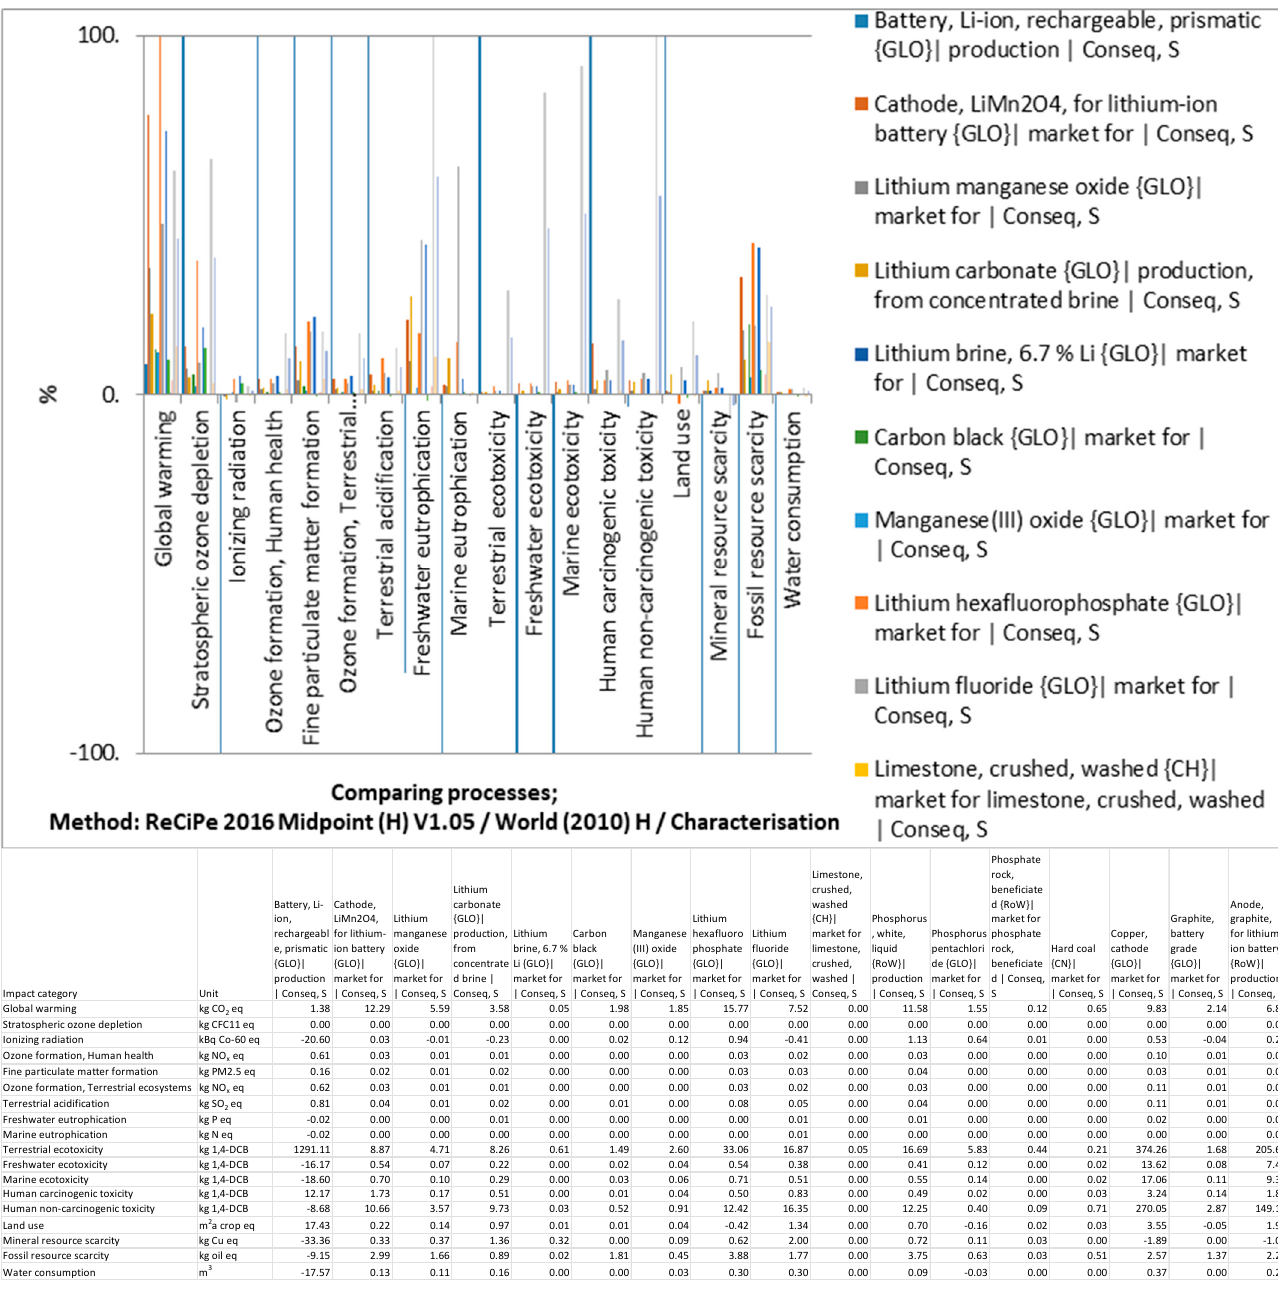
Figure 5. ReCiPe (M) (H) life cycle impact characterisations of 1 kg of each key material shown in Table 1. 1,4 DCB: 1,4-dichlorobenzene. CFC11: chlorofluorocarbon. GLO: global. RoW, rest of the world and CH: Switzerland in Ecoinvent.